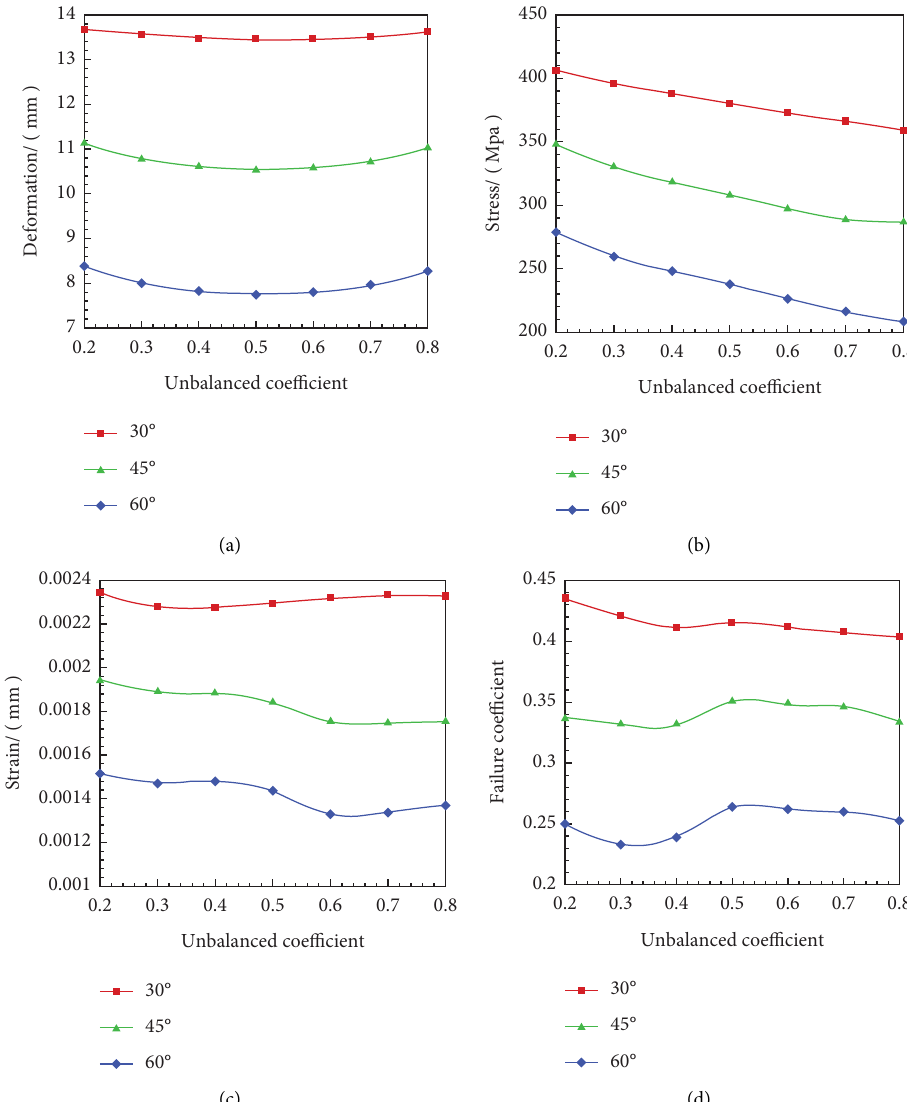
Figure 9: Structural displacement, stress, strain, and failure at diferent unbalanced coefcients. (a) Displacement curve. (b) Stress curve. (c) Strain curve. (d) Failure coefcient change